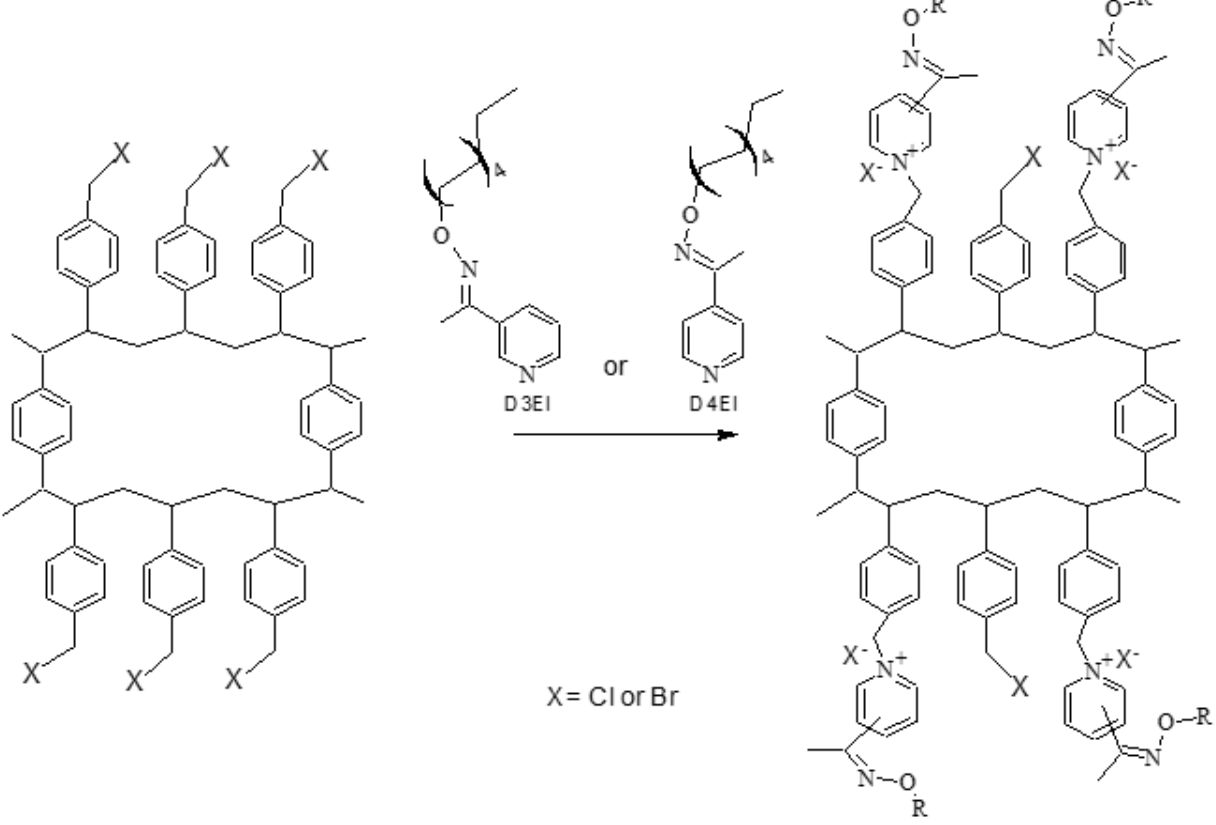
Figure 1. Scheme of the functionalization with D3EI and D4EI.